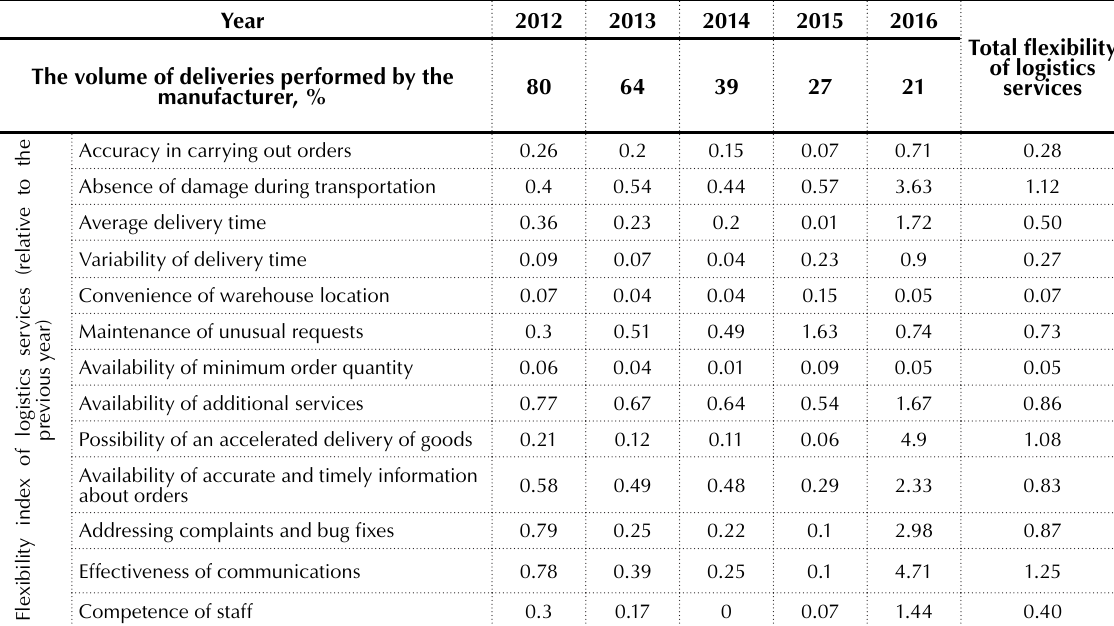
Table 2. Flexibility of indicators of logistics services Sumy Engineering Works Ltd.